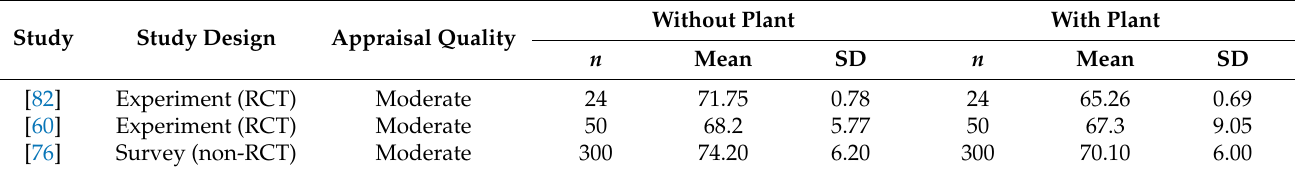
Table 8. Original data of the studies examining the influence of indoor plants on DBP.